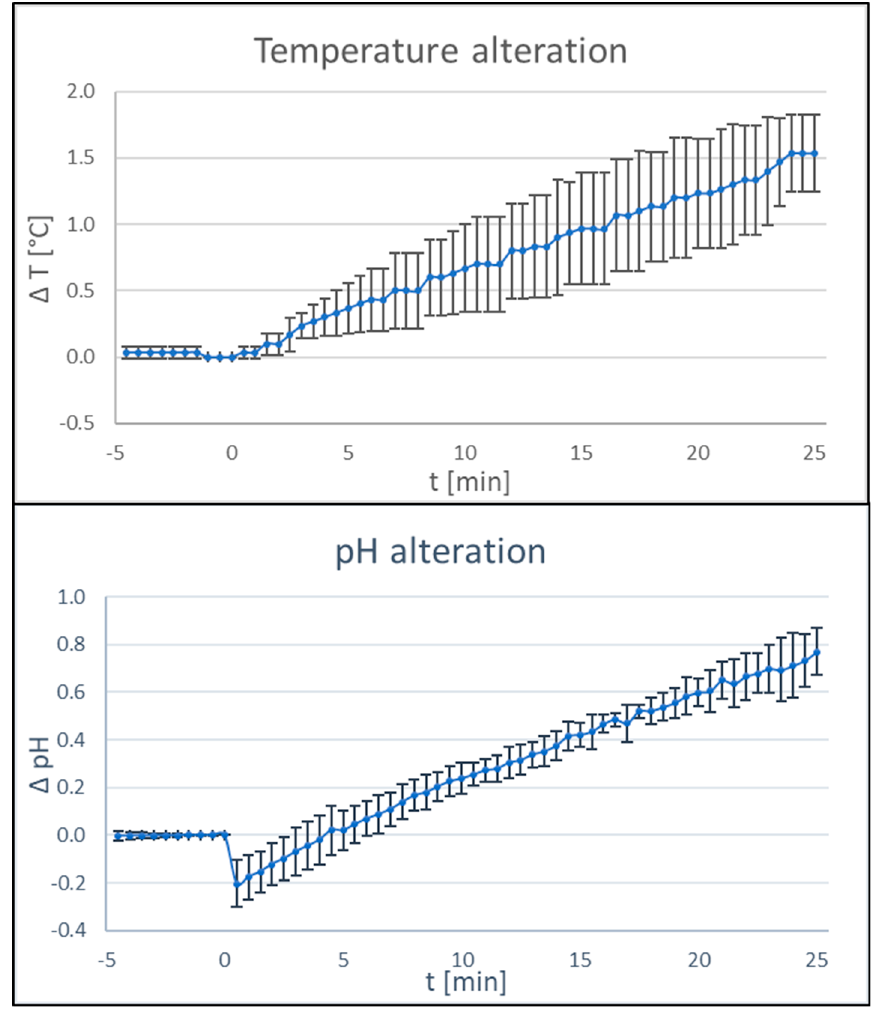
Figure 9. Influence of BDD electrode treatment on physico-chemical parameters. Changes in pH (upper panel) and temperature (lower panel) during application of the BDD electrode in phosphate-buffered saline was tested. For each parameter, three independent experiments were carried out ( n = 3, current 15–20 mA; voltage 6 V).